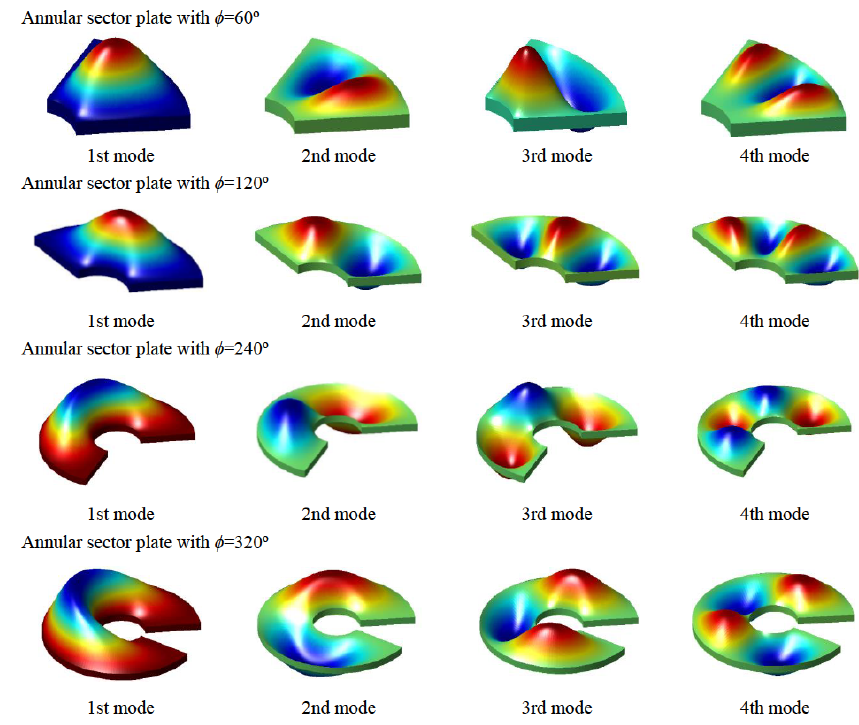
Figure 3: Mode shapes of FGX-CNT reinforced composite annular sector plates with CCCC boundary condition